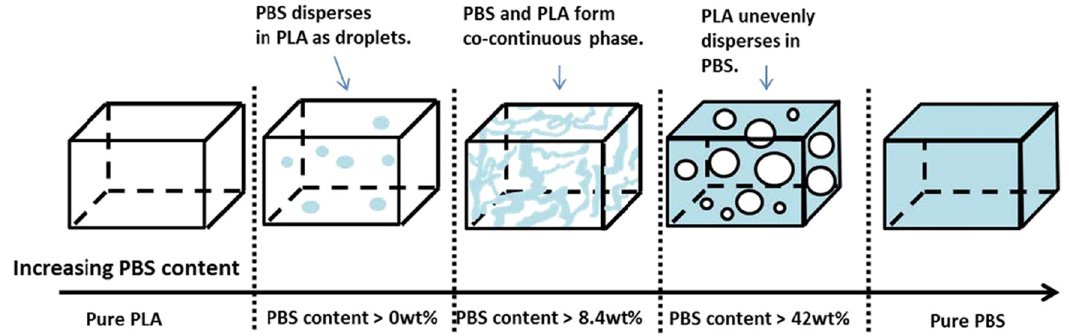
Figure 1: Schematic diagrams of the morphological evolution of PBS/PLA blends ( 24 ) . Copyright 2015. Reproduced with permission from Elsevier.